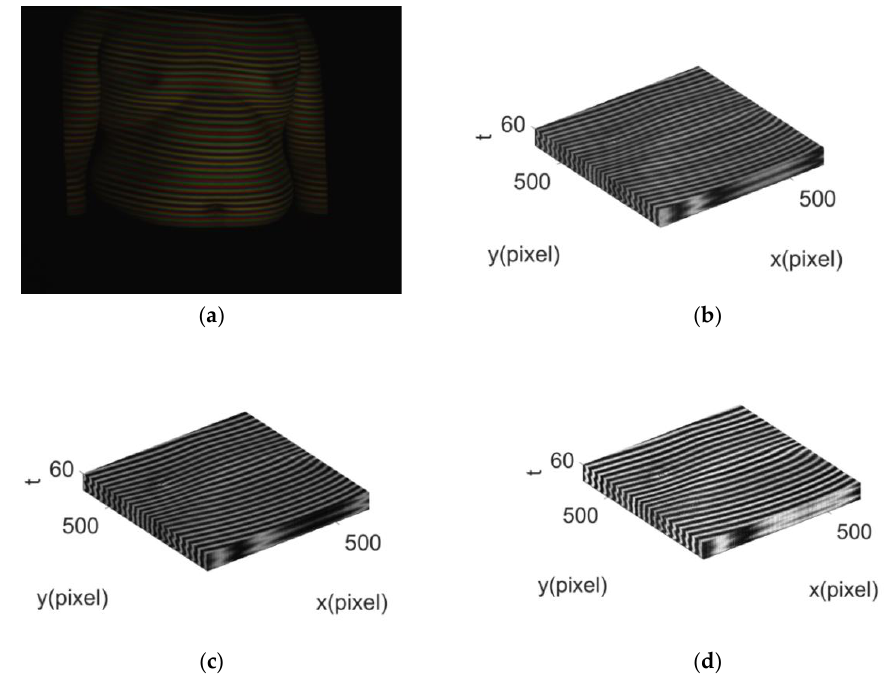
Figure 7. Real human thoracic and abdominal surface reconstruction. ( a ) Thoracic and abdominal surface after projecting color fringe pattern; ( b ) separated fringe image sequence of red channel; ( c ) separated fringe image sequence of green channel; ( d ) separated fringe image sequence of blue channel.